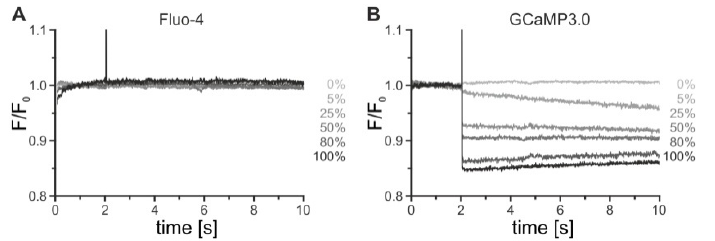
Figure 6. Effects of UV-light application on Fluo-4-loaded or GCaMP3.0-expressing cells. Fluo-4-loaded flpTM-DmOct β 1 ( A ) and flpTM-DmOct β 1-GCaMP3.0 cells ( B ) in extracellular solution were applied to the stopped-flow system and illuminated with a 50 ms UV-flash 2 s after the cuvette was completely filled. Fluorescence was monitored for 10 s. Successive measurements with increasing light intensities (0–100%) were performed. To visualize changes in fluorescence, the fluorescence intensity (F) was normalized to fluorescence intensity before UV-light application (F 0 ) and F/F 0 was plotted over time.